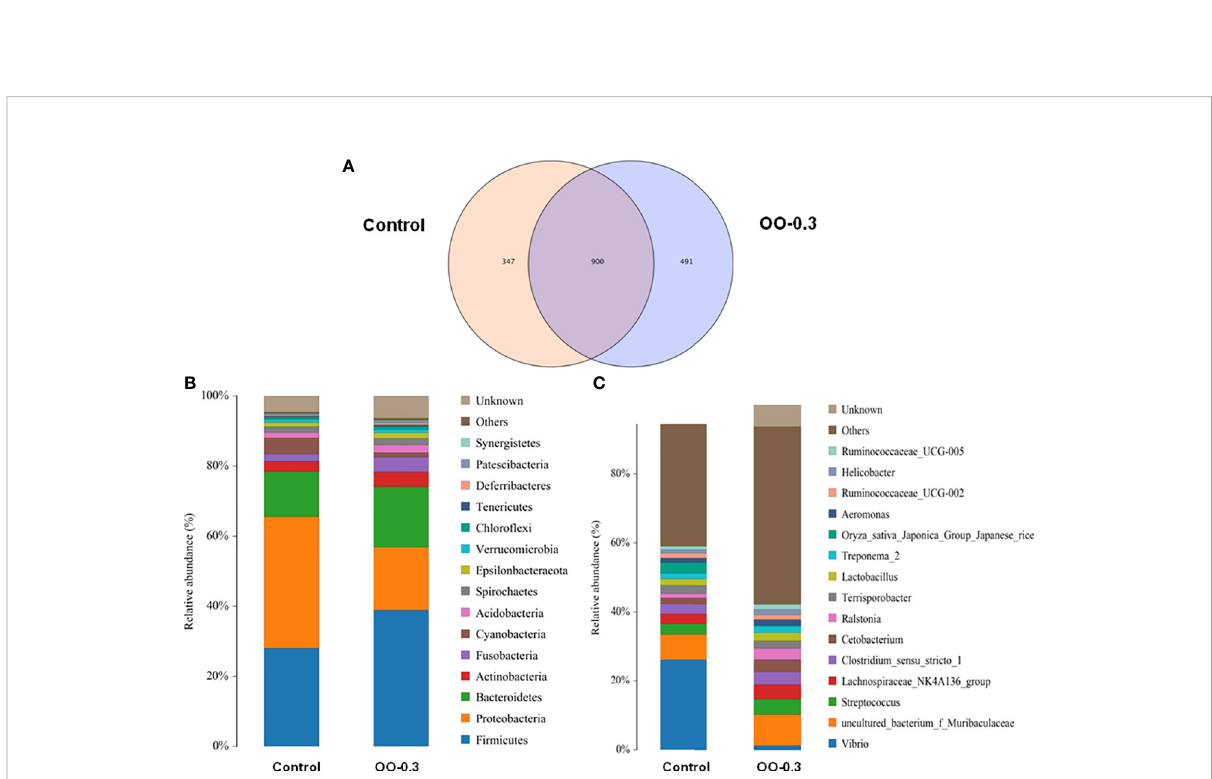
FIGURE 6 Effect of dietary oregano oil (OO) on the composition of intestinal microbiota of juvenile hybrid grouper fed the control and OO-0.3 diets for 8 weeks. Venn diagrams analysis at the (A) OUT level, (B) phylum level, and (C) genus level.